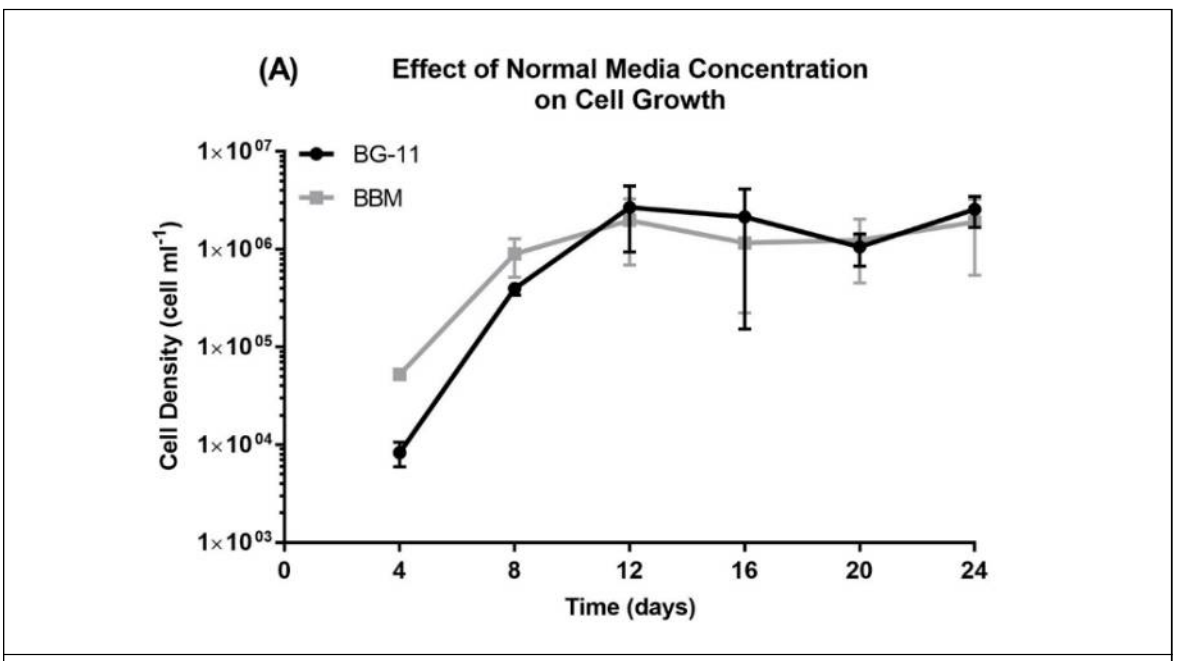
Figure 2: Growth curves studying the effect of media on microalgae growth. Monitoring of microalgae growth in culture. (A) Growth curve for the 1x of the tested media: BG-11 (black) and BBM (grey). (B) Growth curve of reduced media BG-11 0.1× and BBM 0.1× . (C) Growth curve of the media enriched with vitamins. Data represent means ± SD of three replicas per medium. Samples were cultured in an environmentally controlled growth chamber under a light intensity of 28 µ mol m -2 s -1 with 12:12 h, light:dark cycle at 22 ± 1